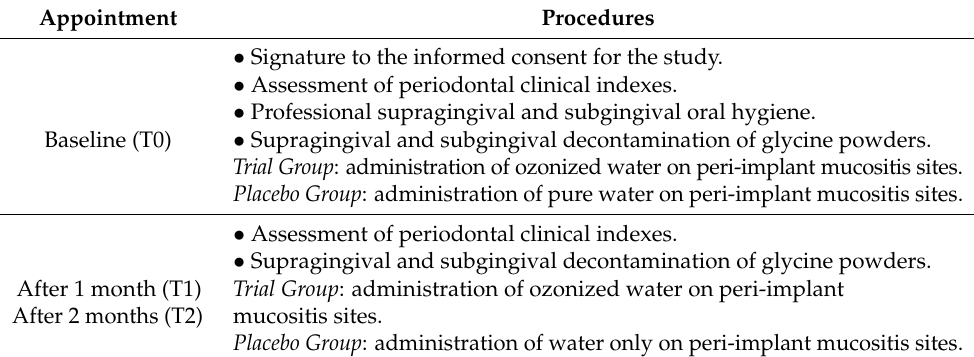
Table 1. Protocol adopted for the